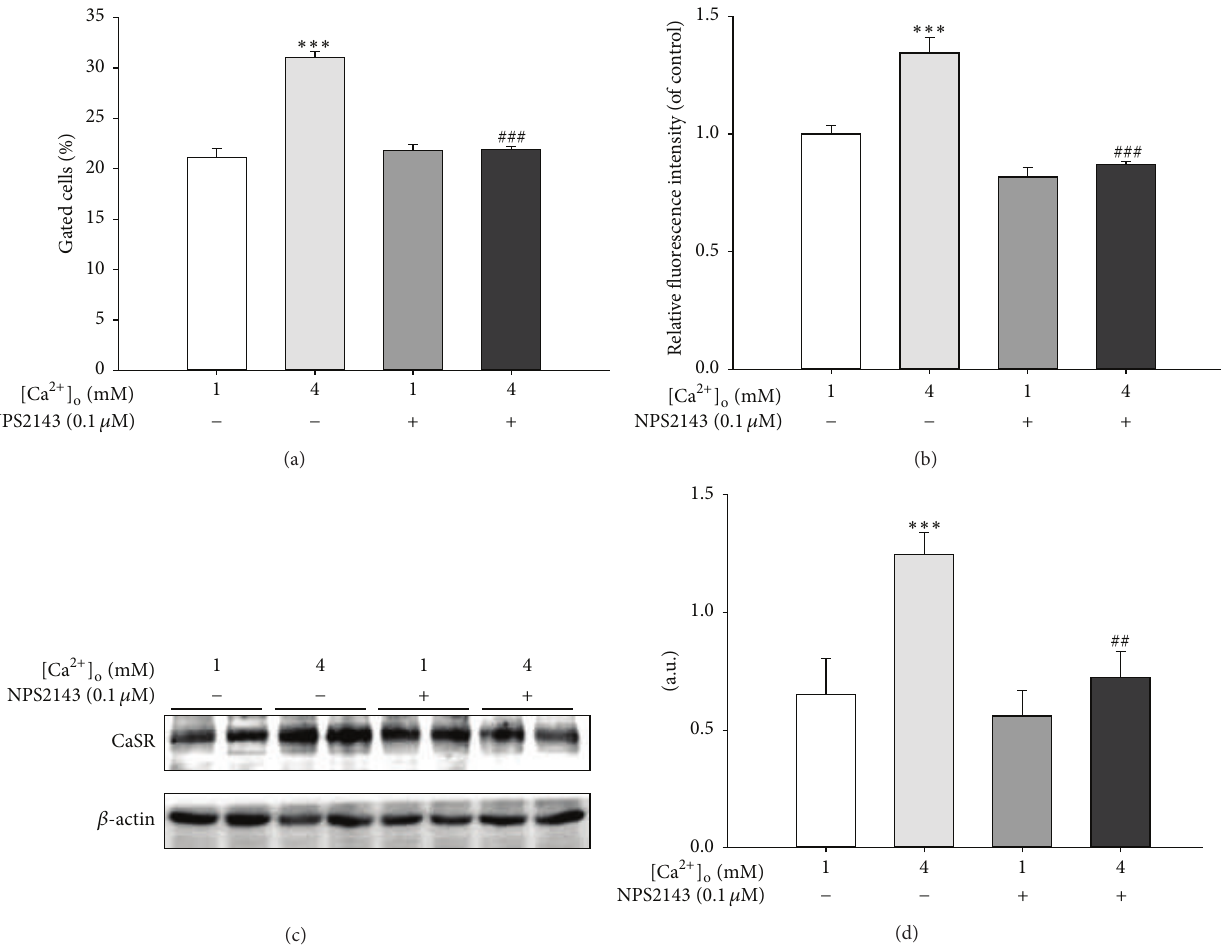
Figure 3: CaSR inhibition blocked the increase of [ Ca 2+ ] i in response to [ Ca 2+ ] o during the proliferation of pBMSCs. (a) [ Ca 2+ ] i of live cells were analyzed by flow cytometry. The percentage of gated positive cells represented the cells stained with Fluo 3-AM. Representation of three independent experiments with similar results. (b) The relative FITC fluorescence intensity of gated positive cells. (c) Western blot analysis of CaSR in pBMSCs after 5-day culture in the presence of 4mM [ Ca 2+ ] o and/or 0.1 𝜇 M NPS2143. 𝛽 -actin was used as loading control. (d) Mean ± SEM of immunoblotting bands of CaSR; the intensities of the bands were expressed as the arbitrary units ( 𝑛 = 4 ). ∗∗∗ 𝑃 < 0.001 versus 1mM ## 𝑃 < 0.01 and ### 𝑃 < 0.001 versus 4mM [ Ca 2+ ] [ Ca 2+ ] o group (control); o group.